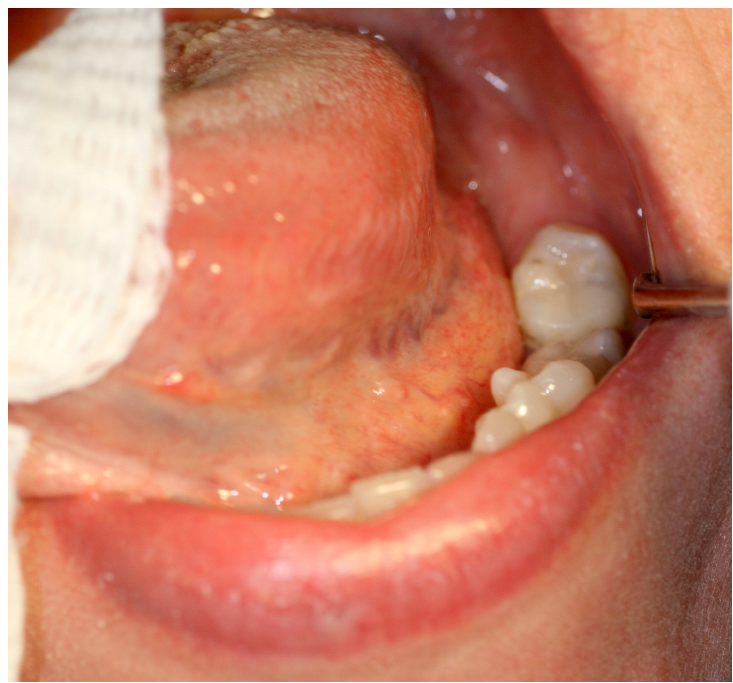
Figure 2. Composite resin restorations on 3.6 and 3.7 teeth after the removal of the amalgams. Appl. Sci. 2022 , 12 , x FOR PEER REVIEW